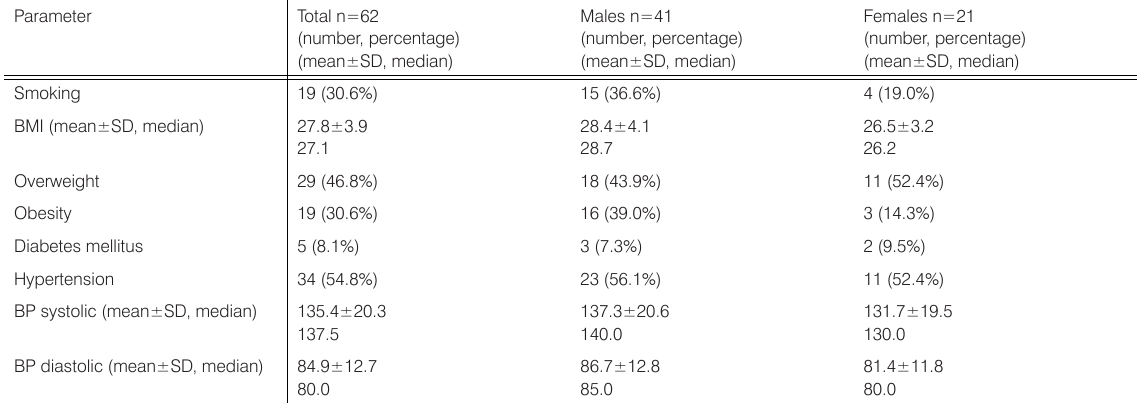
Table 1. Clinical characteristics of